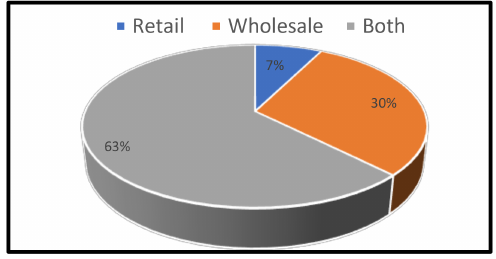
Figure 7. Activities of the vegetable seed business.